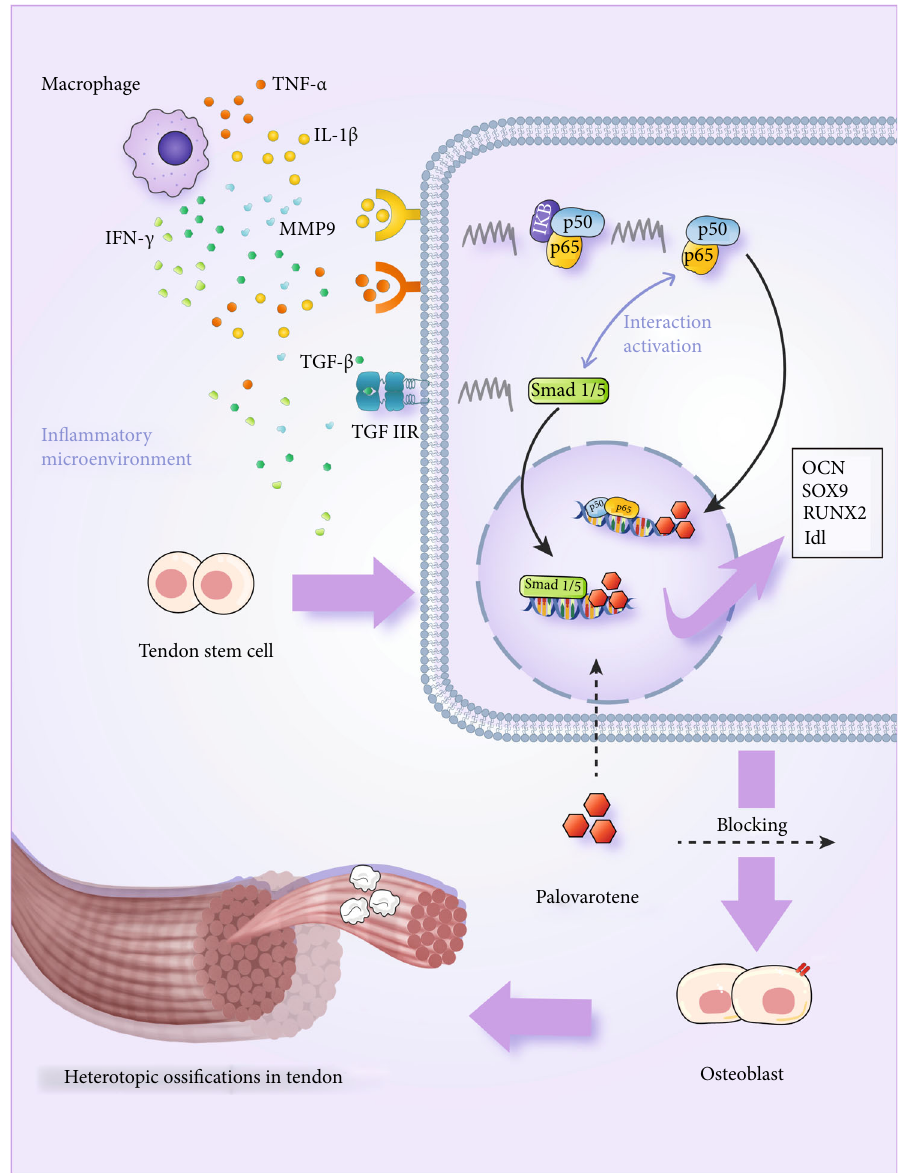
Figure 7: A demonstration of palovarotene ’ s e ff ects and the synergistic e ff ects of Smad and NF- κ B signaling pathways following stimulation of the in fl ammatory